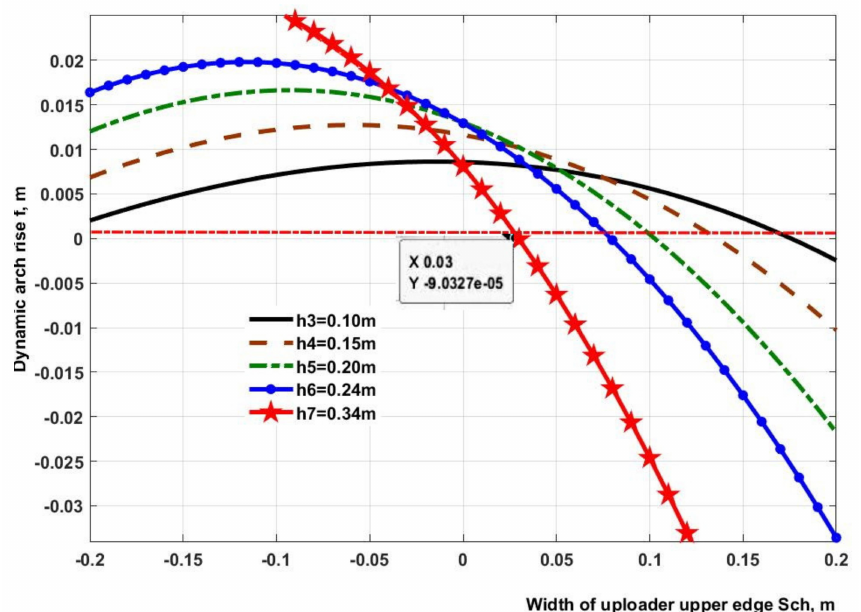
Figure 4. Variation of bridging rise f over the width of unloading hopper Sch depending on the width of the bridging base in the unloading hopper of a convective-microwave plant. Graphs show that the slope of the curve representing the bridging rise grows sharply with the value of the height of the bridging base exceeding 0.2 m. For a bridging base height of 0.34 m, it attains its maximum value, indicating inhomogeneous behavior of grain flow from the hopper outlet hole. It is necessary to estimate the difference of grain volumes flowing from the right and the left sections through the hopper outlet hole. For this purpose, the position of the upper edge of bridging in relation to the hopper outlet hole was graphically represented as shown in Figure 5.